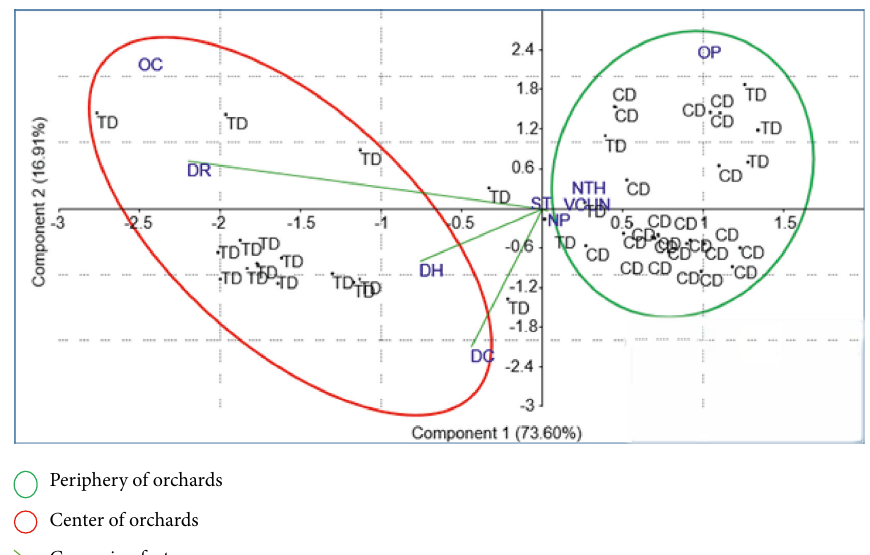
Figure 5: Segregation of nesting sites and supporting-trees (OC: center of the orchard; OP: periphery of the orchard) between turtle dove (TD) and collared dove (CD), and predicting factors of sampled nests (DC: distance to adjacent cereals; DH: distance to adjacent human infrastructure; DR: distance to adjacent road; NP: number of the employees in the orchard; NTH: nesting-tree-height; ST: supporting tree; VCUN: herbaceous plants under the nesting tree). Table 1: Comparison of nest placement and dimension ( n � 60 nests) parameters between dove species and magpie (mean ± SE) was tested using one-way ANOVA. (NBD: big nest diameter, NDLC: distance between nest and the lower canopy, NDCT: distance of nest to tree center, NDP: nest depth, NSD: small nest diameter, NHG: nest height upon the ground, NTH: nesting tree height). Species Test Nesting parameters Turtle dove Collared dove Magpie NBD NDCT 106.10 ±